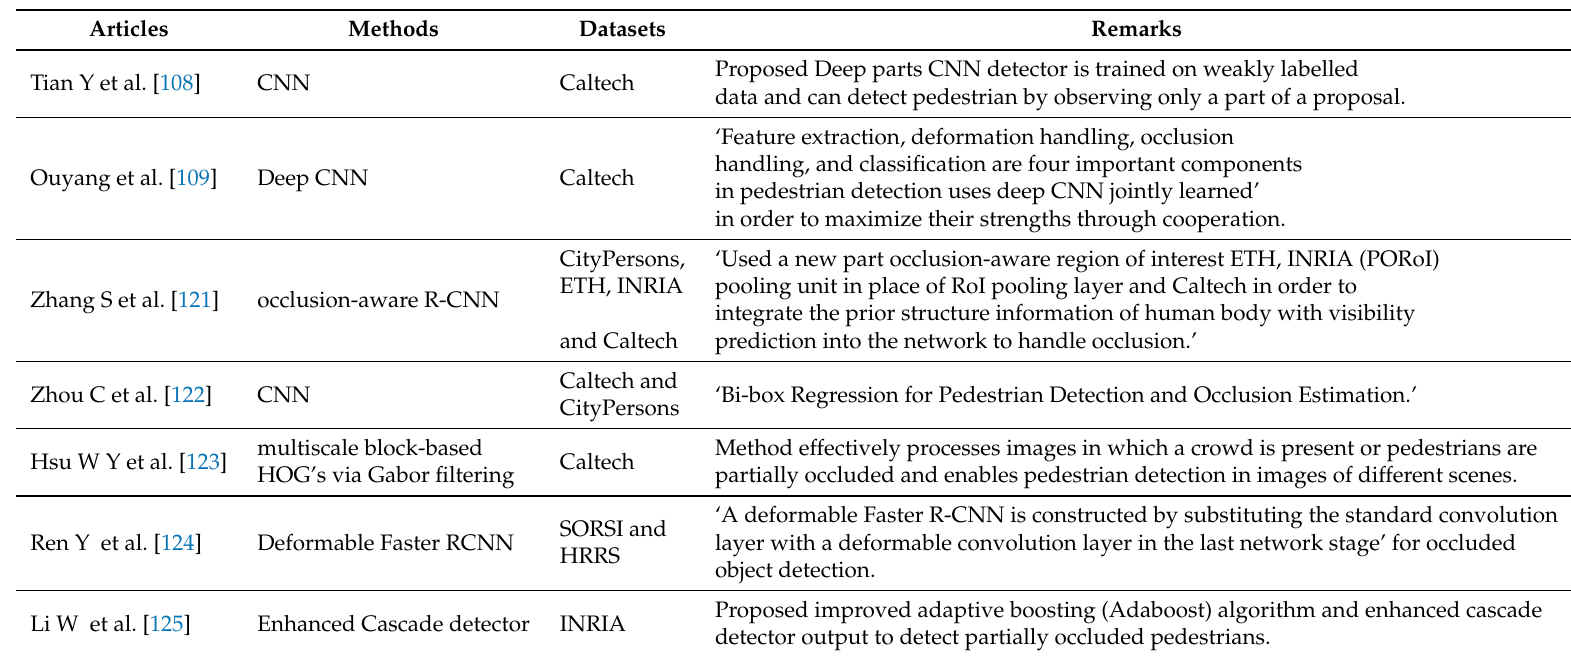
Table 9. Various techniques to handle occlusion situations while detecting